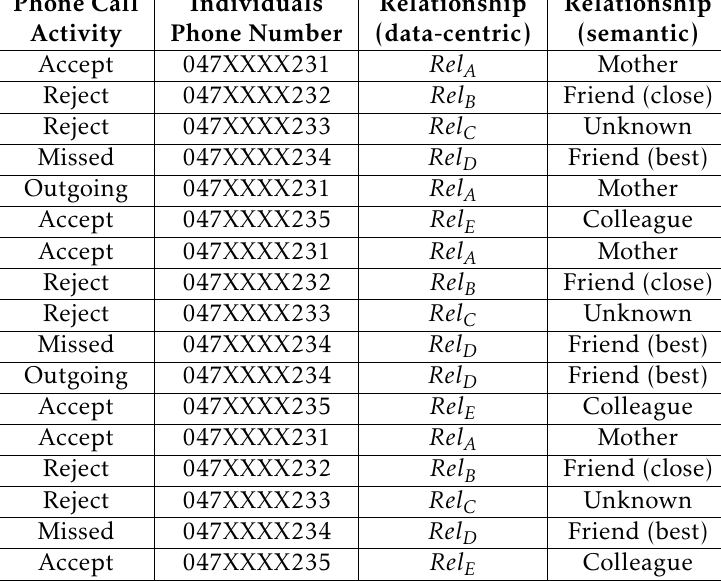
Table 1. Sample examples of individuals’ data-centric social relational contexts and corresponding semantic social